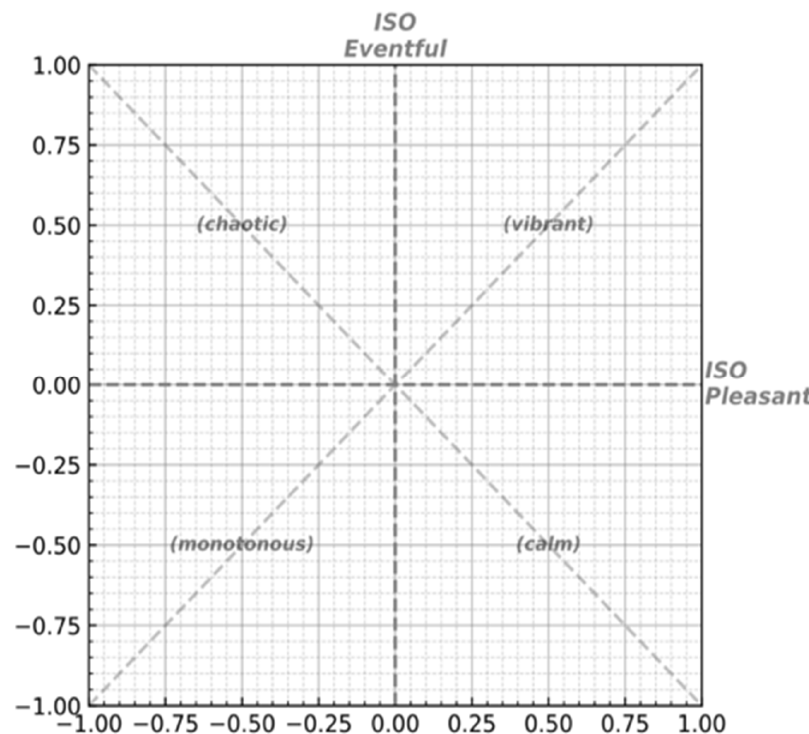
Figure 2. Interface of